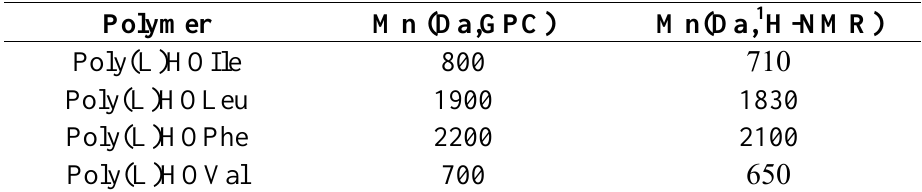
Table 2. Comparison between Mn obtained from GPC and Mn obtained from the 1 H-NMR spectrum for the analyzed